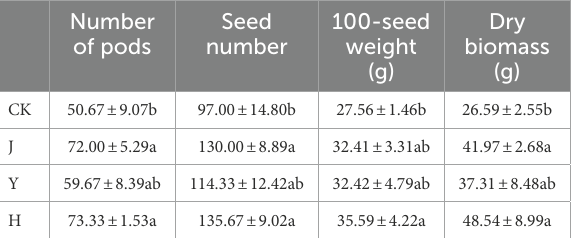
TABLE 7 Comparison of soybean yield after treatment with various bacterial inoculants. Number of pods